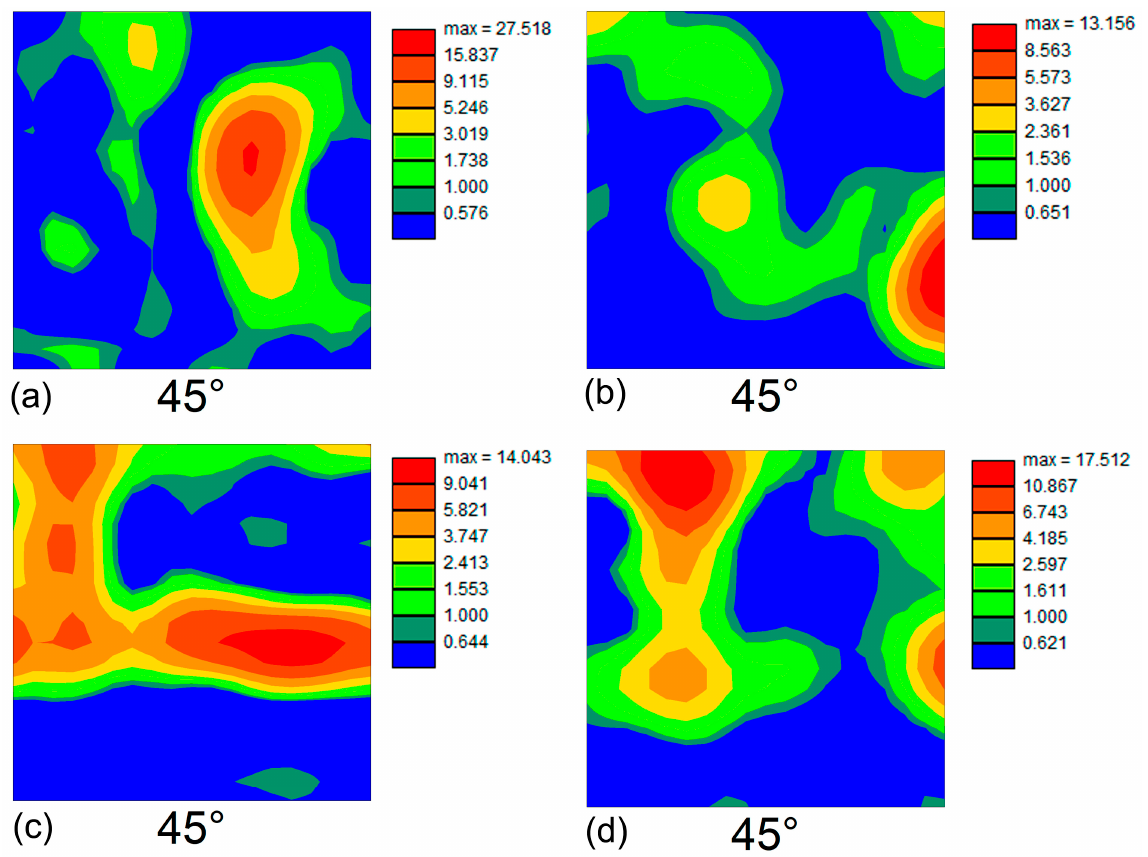
Figure 4. Orientation distribution functions (ODF) at φ 2 = 0° of the steel after tempforming at ( a , c ) 600 °C to total strains of ( a ) 0.89 and ( c ) 1.4 and ( b , d ) at 650 °C to total strains of ( b ) 0.5 and ( d ) 1.4. Table 4. Microstructure parameters of steel processed by tempforming.